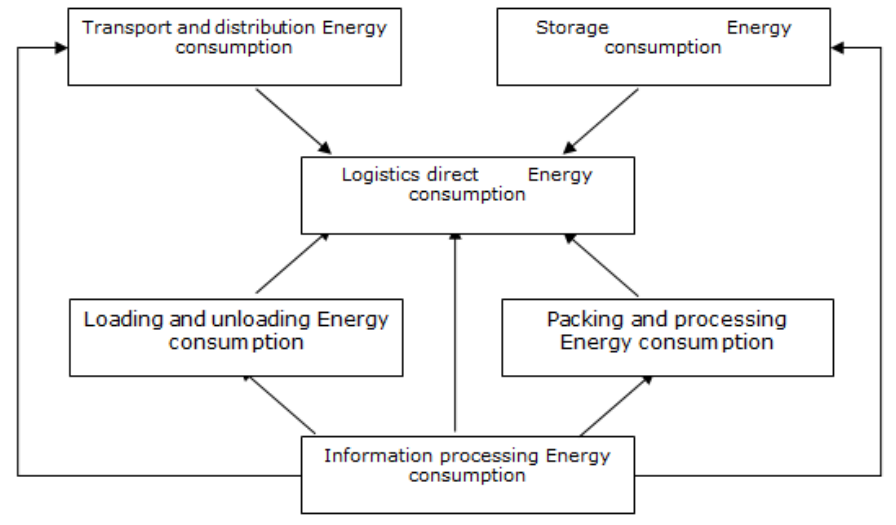
Figure 1. Logistics direct energy consumption